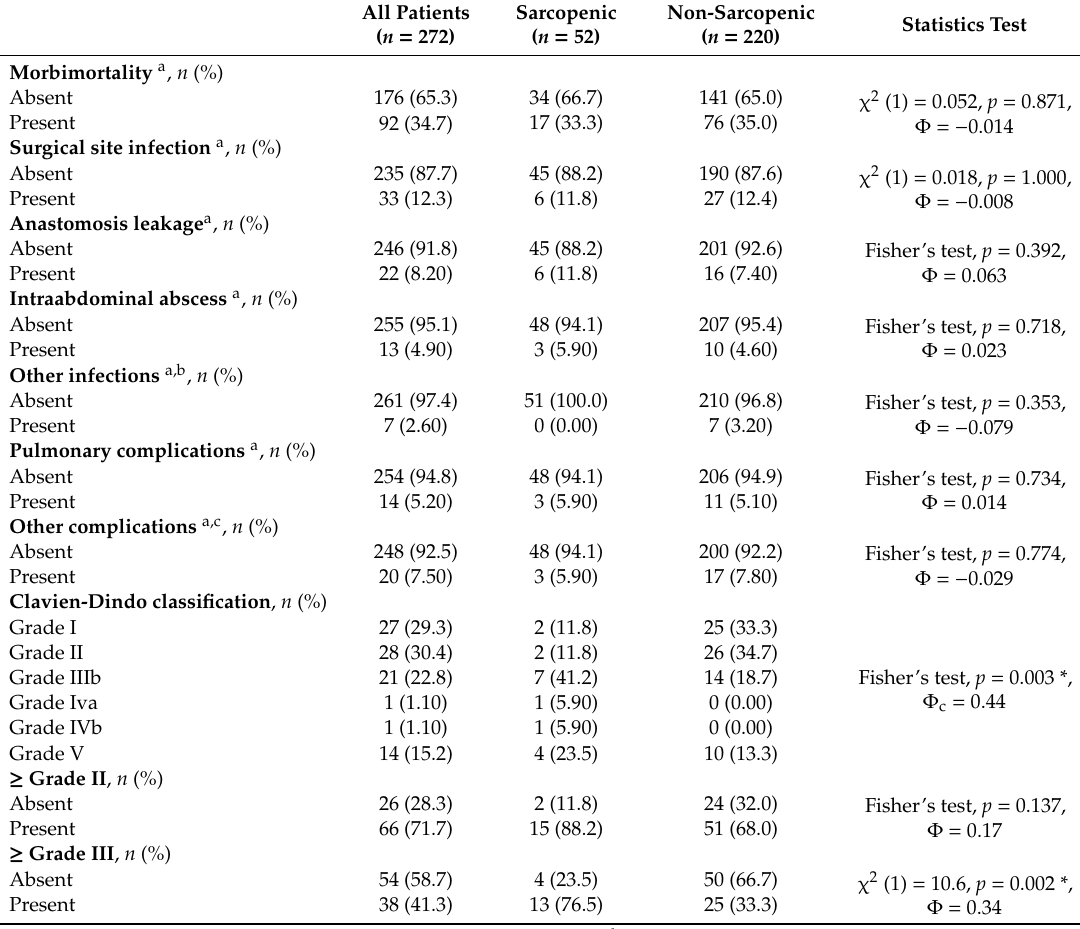
Table 3. Relationship between sarcopenia and postoperative